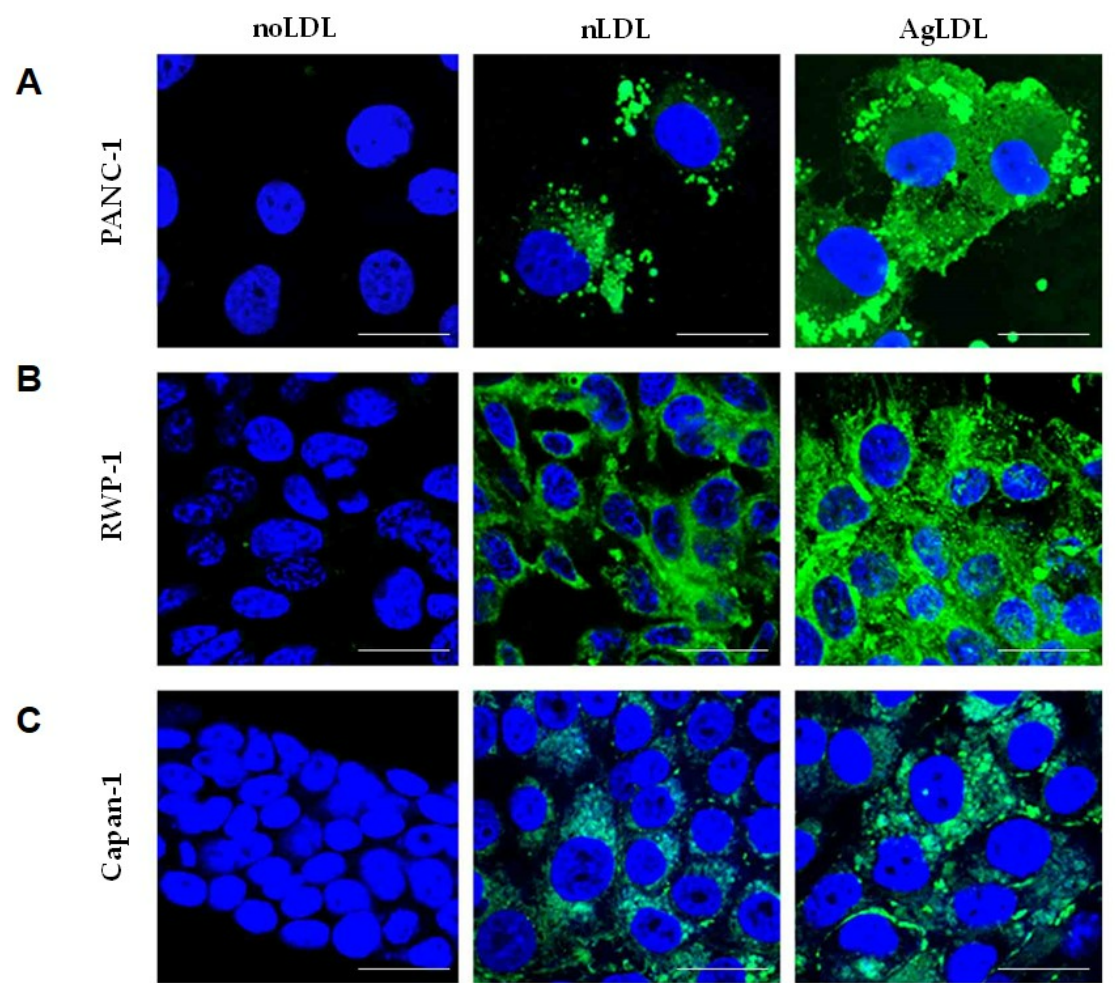
Figure 3. Effects of nLDLs and AgLDLs on lipid droplet formation in pancreatic tumor cell lines. Confocal laser microscopy images show BODIPY-stained lipid droplets (green dots) and nuclei (blue) in the ( A ) PANC-1, ( B ) RWP-1 and ( C ) Capan-1 cell lines. Scale bar, 25 μ m. LDL, low-density lipoprotein; nLDL, native LDLs; AgLDL, aggregated LDLs.